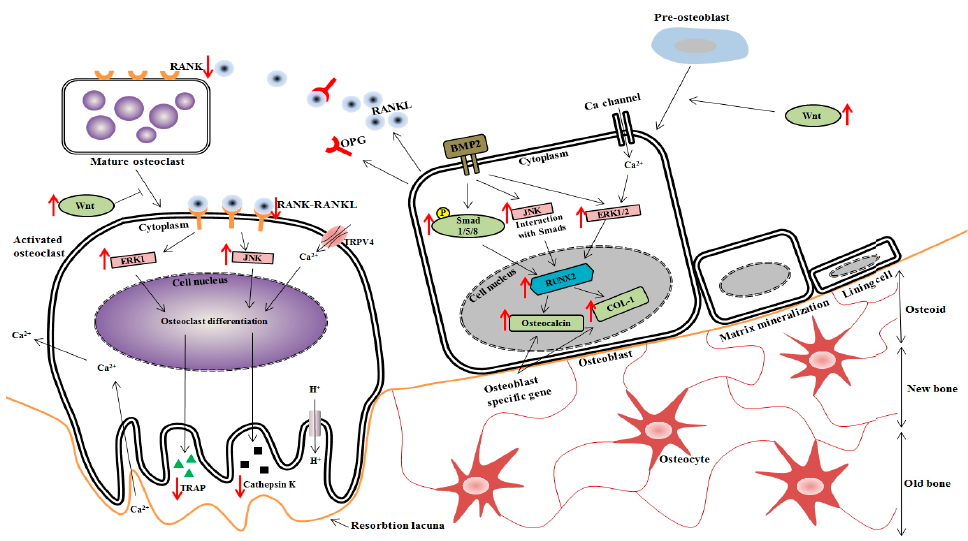
Figure 8. Scheme of Ca signaling derived from Gallus gallus domesticus (GD) on osteoblastogenesis and osteoclastogenesis.